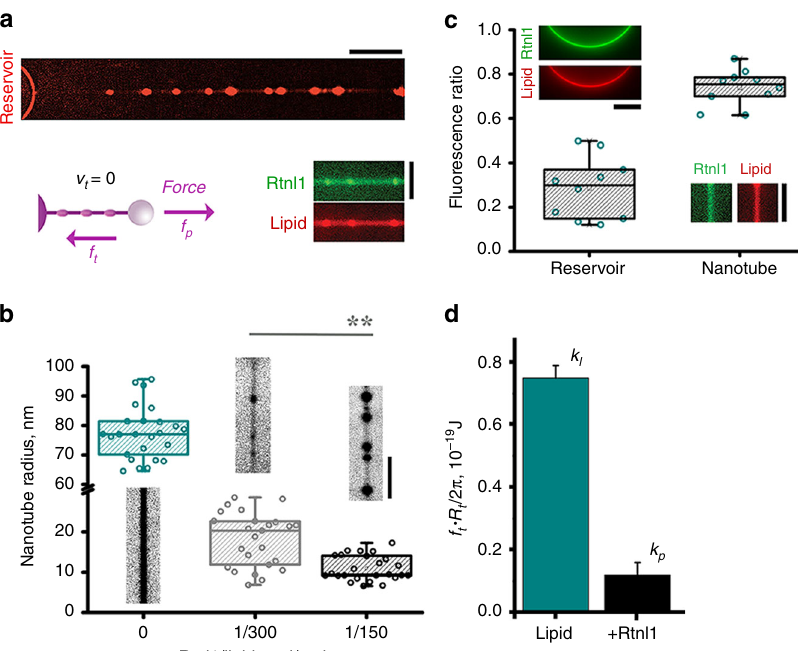
Fig. 4 Static constriction of lipid nanotubes by Rtnl1. a Representative image of Rtnl1-constricted lipid nanotubes (Rh-DOPE fl uorescence is shown) obtained with 1:150 Rtnl1/lipid (mol/mol). Scale bar 10 μ m. The cartoon shows the static force balance f p = f t where the pulling force ( f p ) equals the tensile force ( f t ). The insert shows incorporation of the Alexa488-Rtnl1 (green) into the nanotube (red) at 1:150 protein/lipid. Scale bar 2 μ m. b Boxplots of the radii of the control nanotubes ( n = 25 tubes) and the nanotubes constricted by Rtnl1 at 1:300 ( n = 25 tubes) and 1:150 ( n = 25 tubes) protein/lipid ratio; 3 independent Rtnl1 preparations were used. Representative images of the nanotubes are shown above/below the boxplots (Rh-DOPE fl uorescence is seen, scale bar 2 μ m). Boxplots depict IQR, whiskers indicate minimum and maximum of the dataset. c Differential incorporation of GFP-Rtnl1 into reservoir and nanotube membranes (n = 8 independent nanotube/reservoir pairs). The incorporation was measured as the ratio between the GFP-Rtnl1 and lipid (Rh- DOPE) fl uorescence. Images show representative examples of the reservoir membrane and a constricted part of the nanotube membrane used for calculations (GFP and Rh-DOPE fl uorescence, scale bars 4 μ m). Statistical signi fi cance: unpaired two-tailed t test, ** p < 0.01. d Stabilization of constricted nanotubes by Rtnl1 (1:150 protein/lipid) measured as the decrease of f t R t . Mean R t and f t values are taken from panel ( b ) and Supplementary Fig. 5c, respectively: for pure lipid nanotubes R t = 77.4 ± 1.8 nm n = 25, f t = 6.9 ± 0.4 pN n = 26; for Rtnl1-containing nanotubes R t = 10.9 ± 0.6 nm n = 25, f t = 7.6 ± 2.6 pN n = 10, where n is the number of independently formed nanotubes and errors represent SEM. Source data are provided as a Source Data fi le. Error bars represent SD ( n = 25 tubes for the lipid column, n = 10 tubes for + Rtnl1